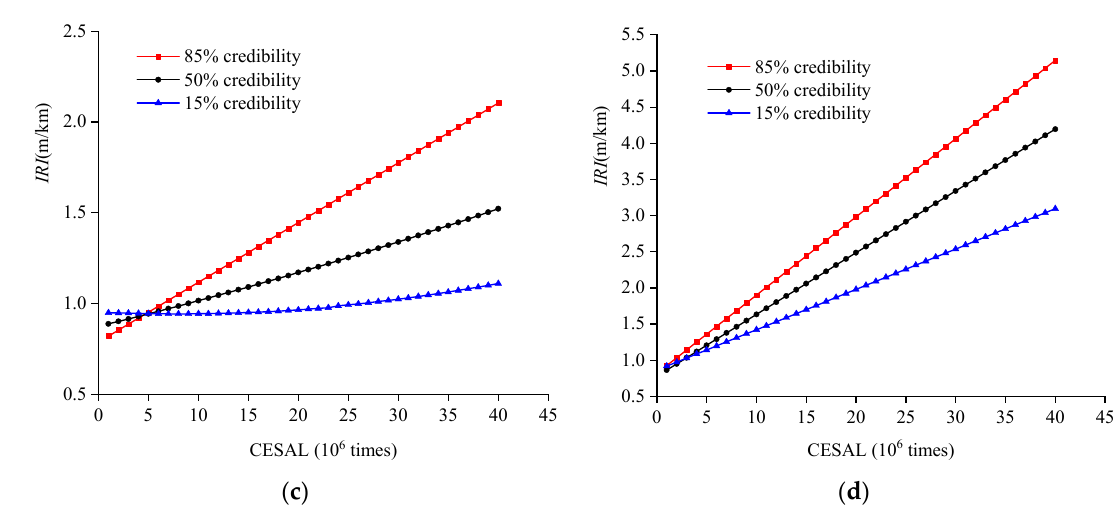
Figure 3. Life-cycle performance model of SBDPS: ( a ) SDPQI of EA system; ( b ) SDPQI of GA system; ( c ) IRI of EA system; ( d ) IRI of GA system; CESAL = cumulative equivalent single axle loads; SDPQI = performance index of SBDPS; IRI = international roughness index.